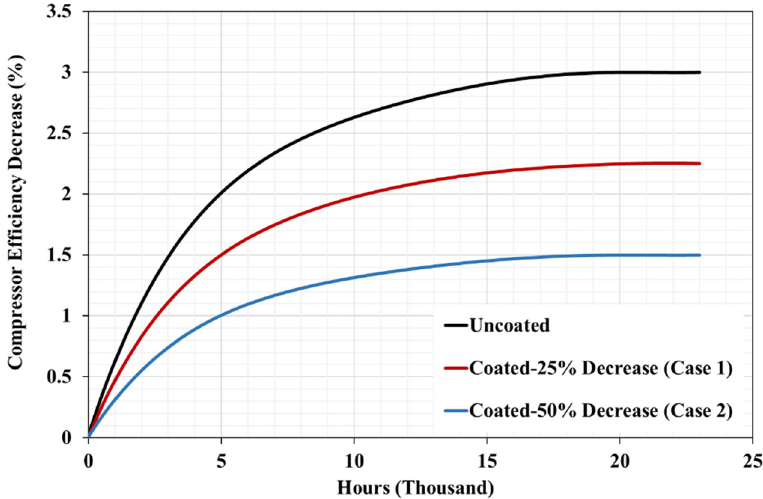
Figure 3. Performance deterioration with service hours.